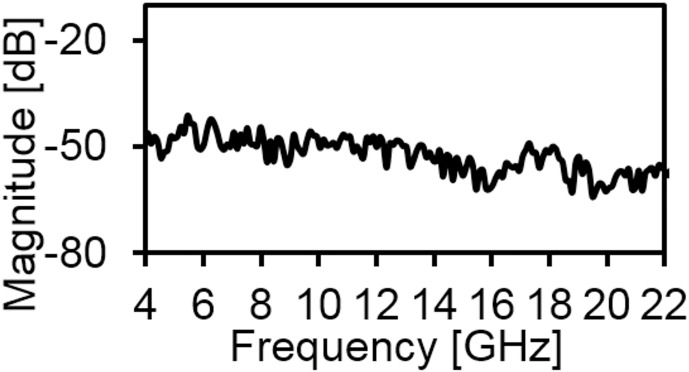
Measured S21 (Magnitude) of the proposed antenna.